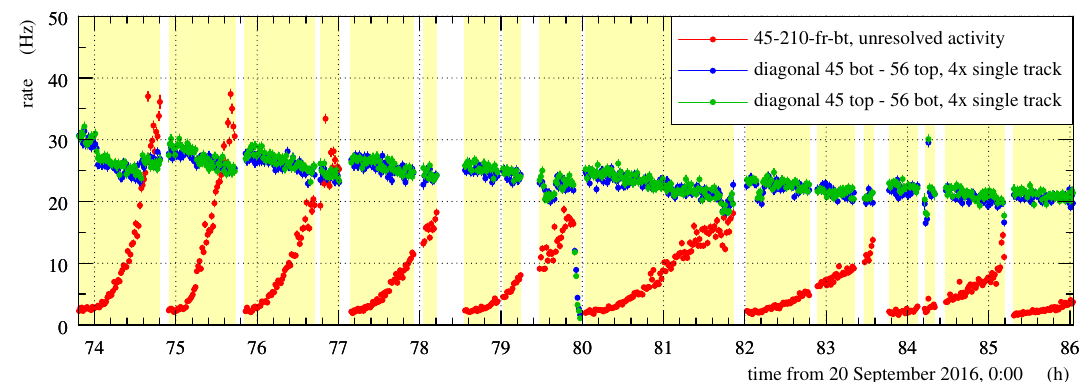
Fig. 2 Event rates from run 5321 as a function of time. The blue and green graphs give rates of fully reconstructed events in the two diagonal configurations relevant for elastic scattering. The red graph shows a rate